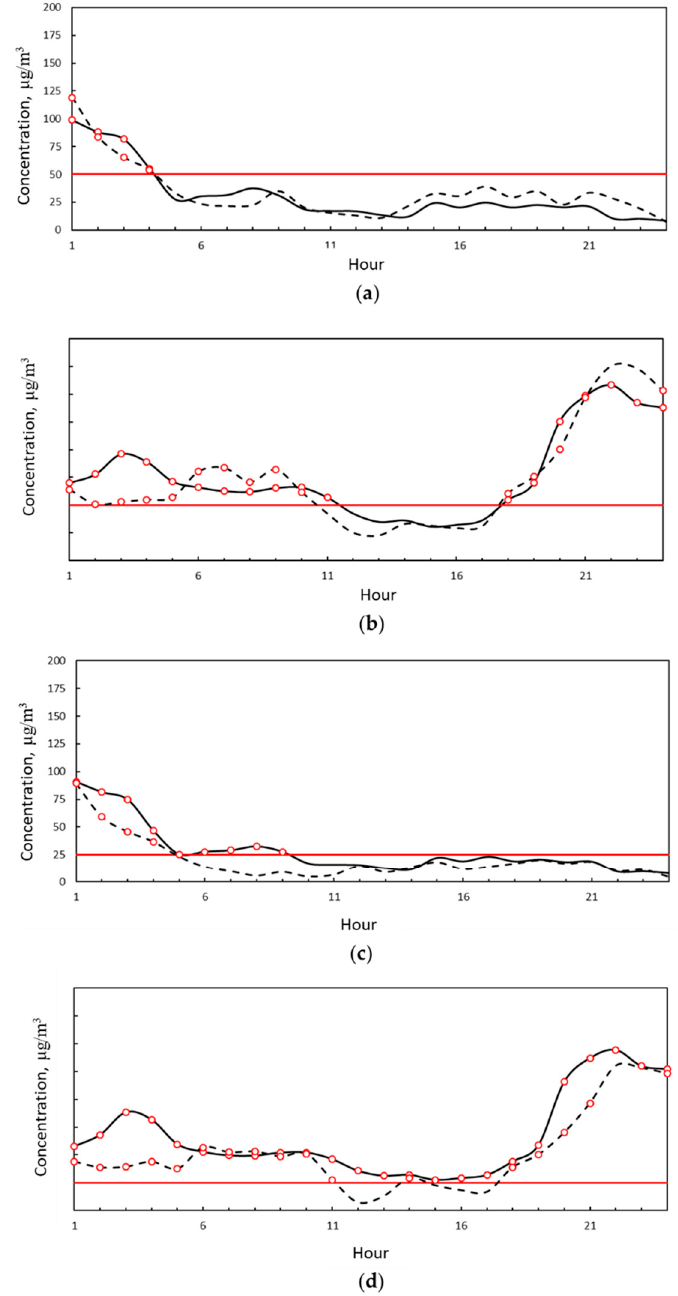
Figure 9. ( a ) PM10 hourly average concentration measured at the VC station (solid black line) and MV station (dashed black line) 3 February 2021. Red line represents the legal limit concentration according to D.Lgs. 155/2010. Red dots represent exceedance of the legal limit. ( b ) PM10 hourly average concentration measured at the VC station (solid black line) and MV station (dashed black line) 21 February 2021. Red line represents the legal limit concentration according to D.Lgs. 155/2010. Red dots represent exceedance of the legal limit. ( c ) PM10 hourly average concentration measured at the VC station (solid black line) and MV station (dashed black line) 3 February 2021. Red line represents the legal limit concentration according to D.Lgs. 155/2010. Red dots represent exceedance of the legal limit. ( d ) PM2.5 hourly average concentration measured at the VC station (solid black line) and MV station (dashed black line) 21 February 2021. Red line represents the legal limit concentration according to D.Lgs. 155/2010. Red dots represent exceedance of the legal limit.